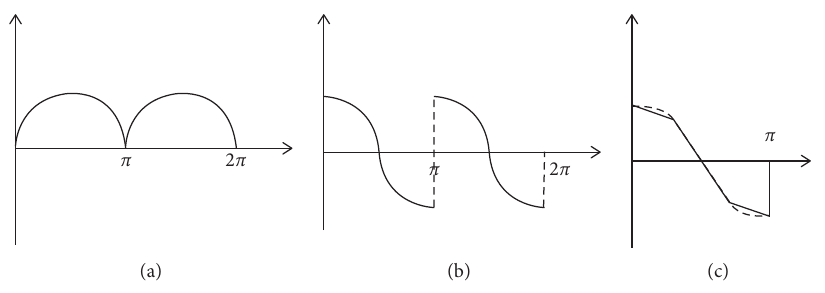
Figure 1: Piecewise linearization of the sine-wave